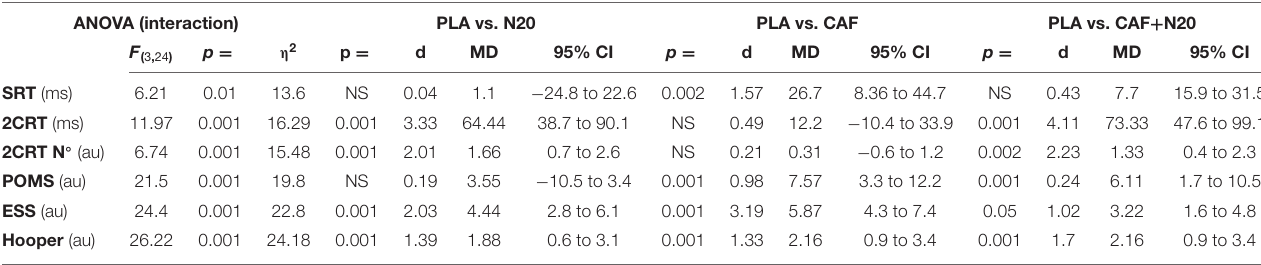
TABLE 1A | Simple and two-choice reaction time and self-administered questionnaires’ ANOVA output and pairwise comparison with PLA after partial sleep deprivation ( study 1 ) . ANOVA (interaction) PLA vs. N20